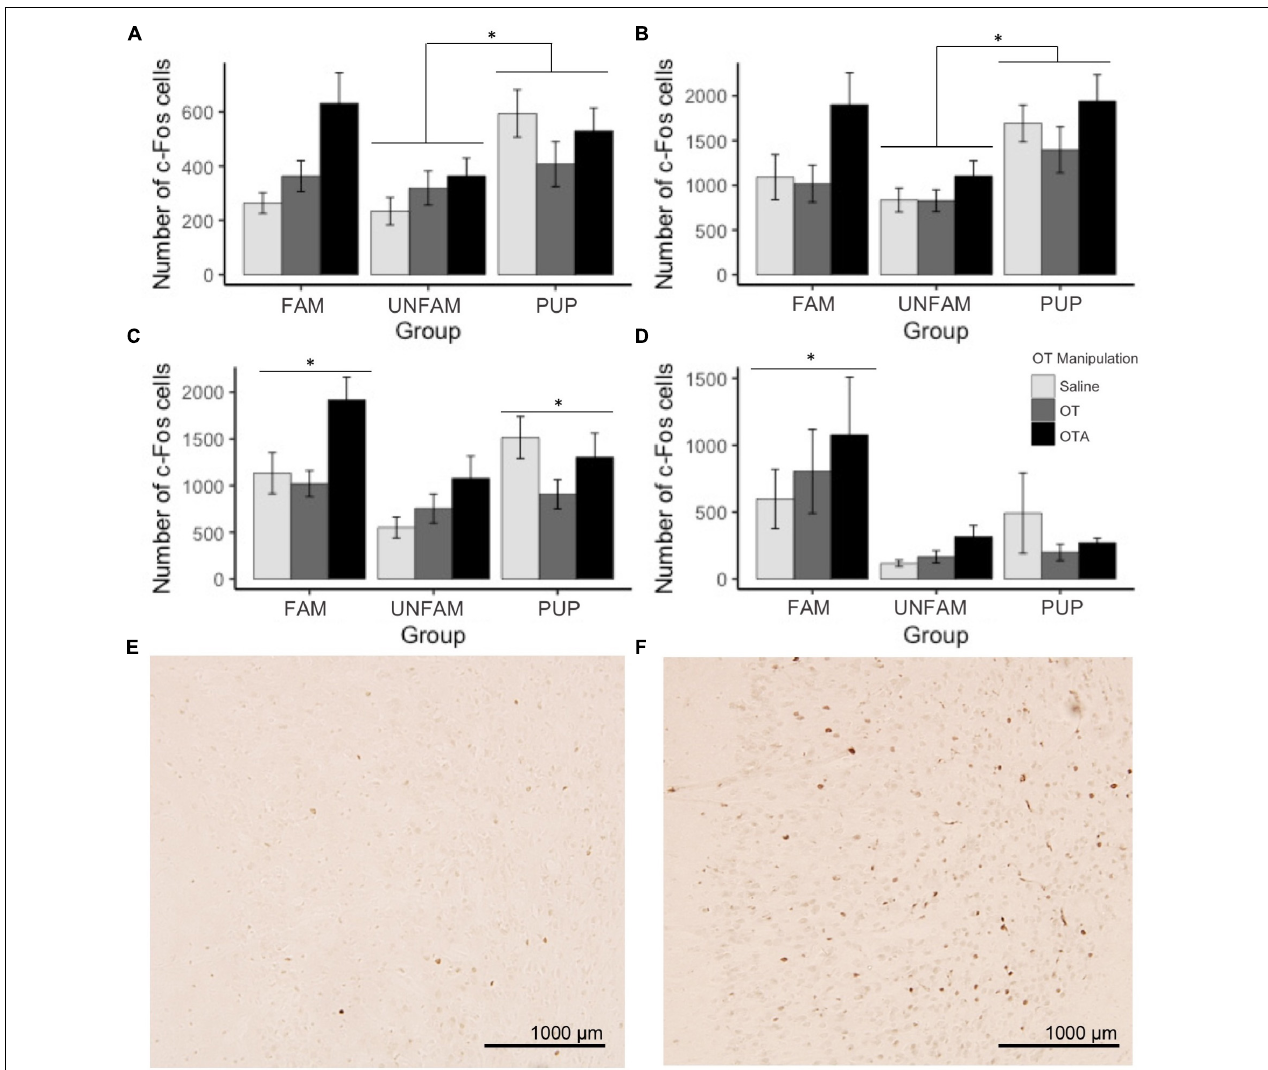
FIGURE 2 | Number of c-Fos cells ± SEM in brain regions where expression significantly varied by behavioral paradigm. UNFAM animals had a significantly lower number of c-Fos cells in the (A) MOB (main effect: p = 0.0011) relative to PUP ( p = 0.002) but not FAM ( p = 0.42), (B) Tu (main effect: p < 0.0001) relative to PUP ( p = 0.00012) and FAM ( p = 0.059), and (C) IL (main effect: p = 0.0015) relative to FAM ( p = 0.002) and PUP ( p = 0.018). (D) FAM animals had a significantly higher number of c-Fos cells in the VP (main effect: p = 0002) relative to UNFAM ( p = 0.0003) and PUP ( p = 0.006). Photomicrographs showing the reduced